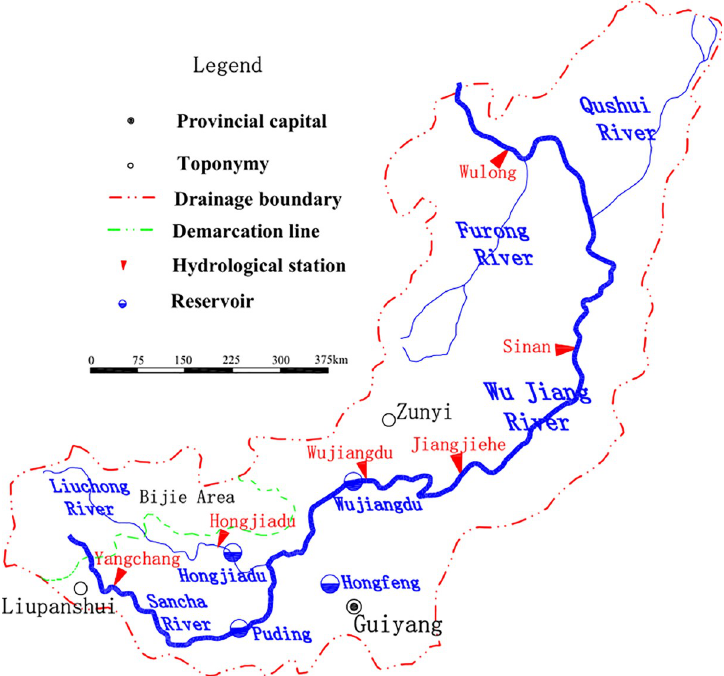
Fig 1. Distribution chart of main hydrometric stations and large hydropower stations in Wu Jiang